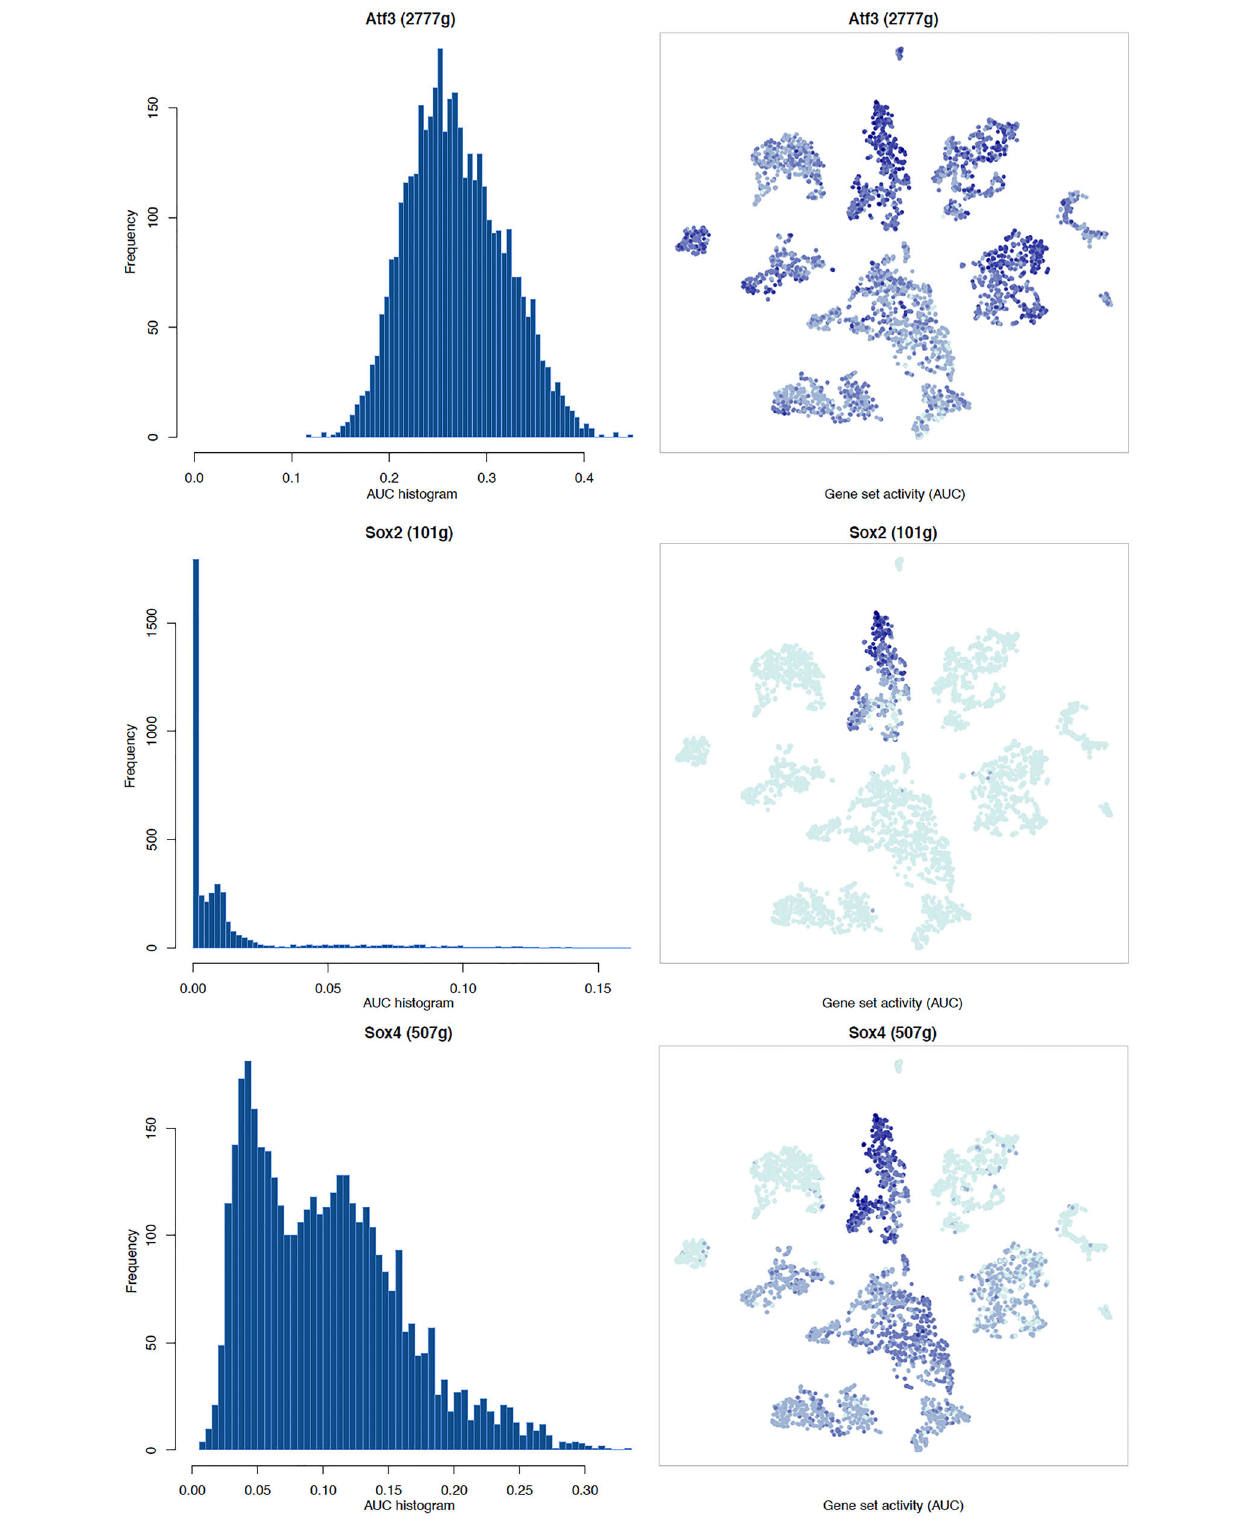
FIGURE 8 | tSNE plots overlayed with regulon activity and histograms showing the distribution of regulon activity of Atf3, Sox2, and Sox4 in day 9 scRNA-seq data set.